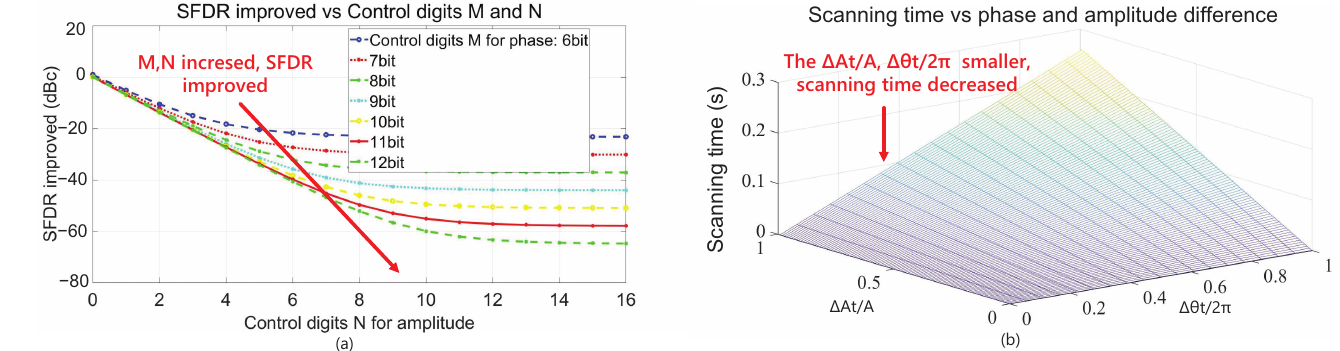
Figure 6. ( a ) Influences of the magnitude and phase quantization bits on SFDR, ( b ) The scanning time vs. ∆ A t and ∆ θ t